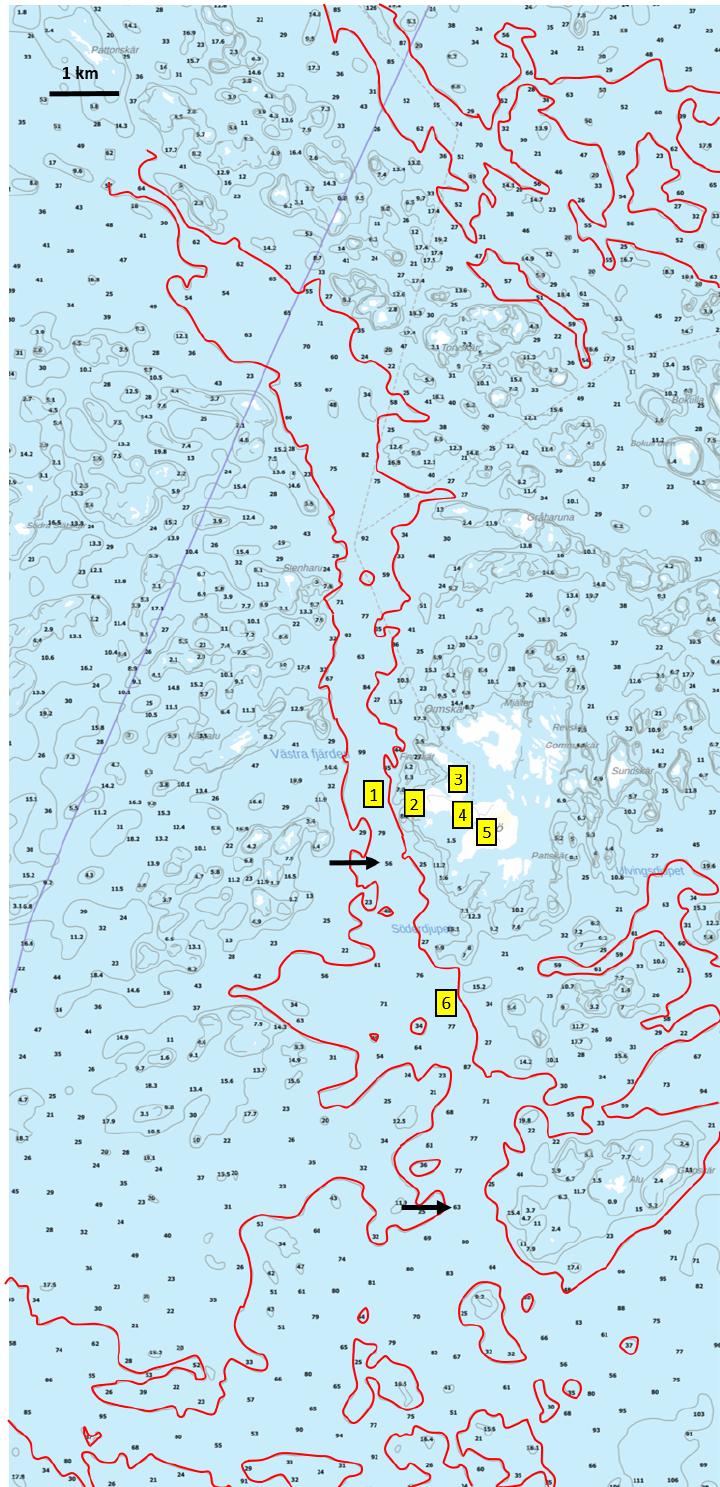
Figure A1. Bathymetry close to Utö Island. 1: hydrographic observations (59 ◦ 46.96 (cid:48) N, 21 ◦ 20.96 (cid:48) E until 2002; currently 59 ◦ 46.97 (cid:48) N, 21 ◦ 20.78 (cid:48) E); 2: marine research station (59 ◦ 46.90 (cid:48) N, 21 ◦ 21.45 (cid:48) E); 3: greenhouse gases (GHGs) and solar radiation (59 ◦ 47.12 (cid:48) N, 21 ◦ 22.04 (cid:48) E); 4: radar (59 ◦ 46.84 (cid:48) N, 21 ◦ 22.13 (cid:48) E); 5: meteorological and air quality station (59 ◦ 46.76 (cid:48) N, 21 ◦ 22.51 (cid:48) E); 6: cabled bottom profiler and ADCP (59 ◦ 45.41 (cid:48) N, 21 ◦ 22.13 (cid:48) E); red line: 50m contour; black arrows: possible sills (60m depth). Map source: National Land Survey of Finland